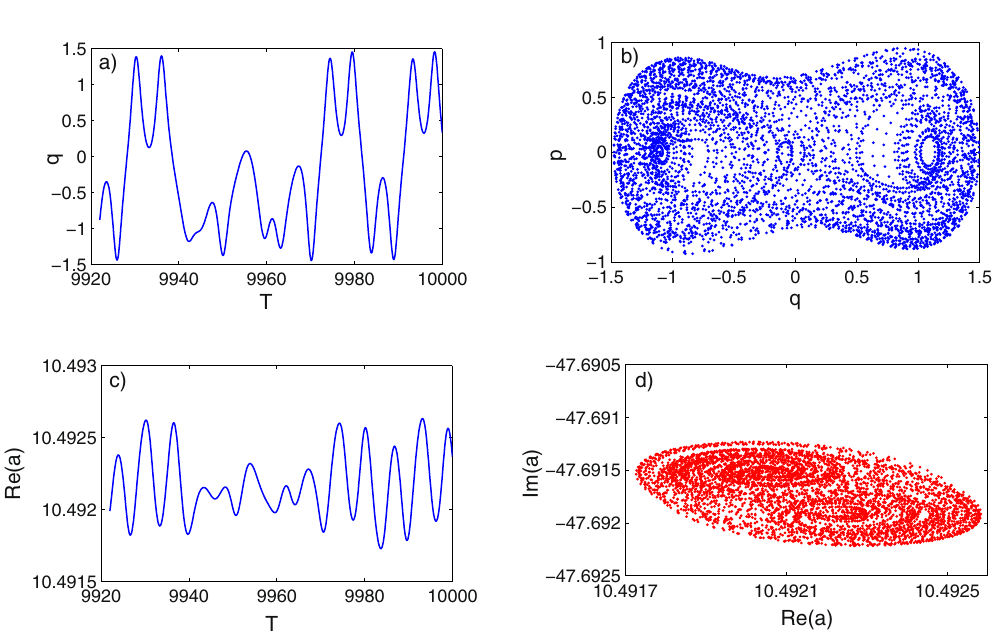
Figure 7. Time series of mechanical state q and optical state a (real part) in ( a ) and ( c ); Corresponding chaotic attractor of mechanical and optical mode in ( b ) and ( d